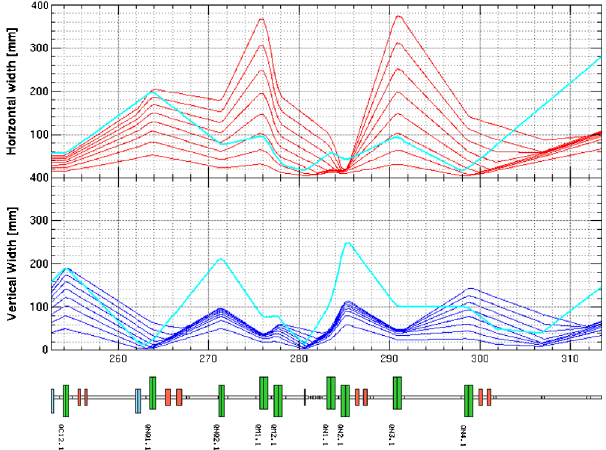
FIG. 13. Calculation of the beam envelope by nonlinear optics in horizontal (red line) and vertical planes (blue line) shown at the top and the bottom, respectively. Each line shows the envelope for each decade from 10 − 8 to 10 − 1 of the total intensity, compared with the envelope obtained using linear optics for 10 − 8 of the total